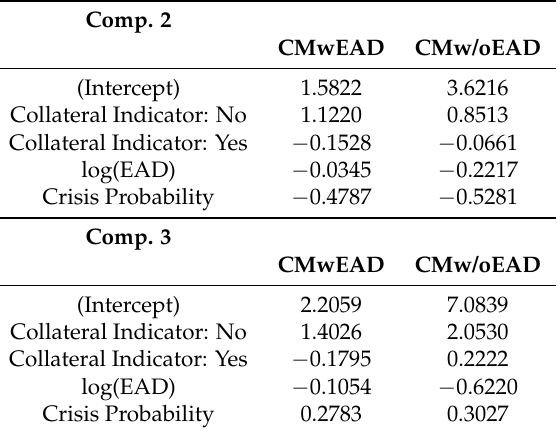
Table 5. Summary of the estimated concomitant variable models CMwEAD (inclusion of the attribute EAD) and CMw/oEAD (exclusion of the attribute EAD). Comp. 2